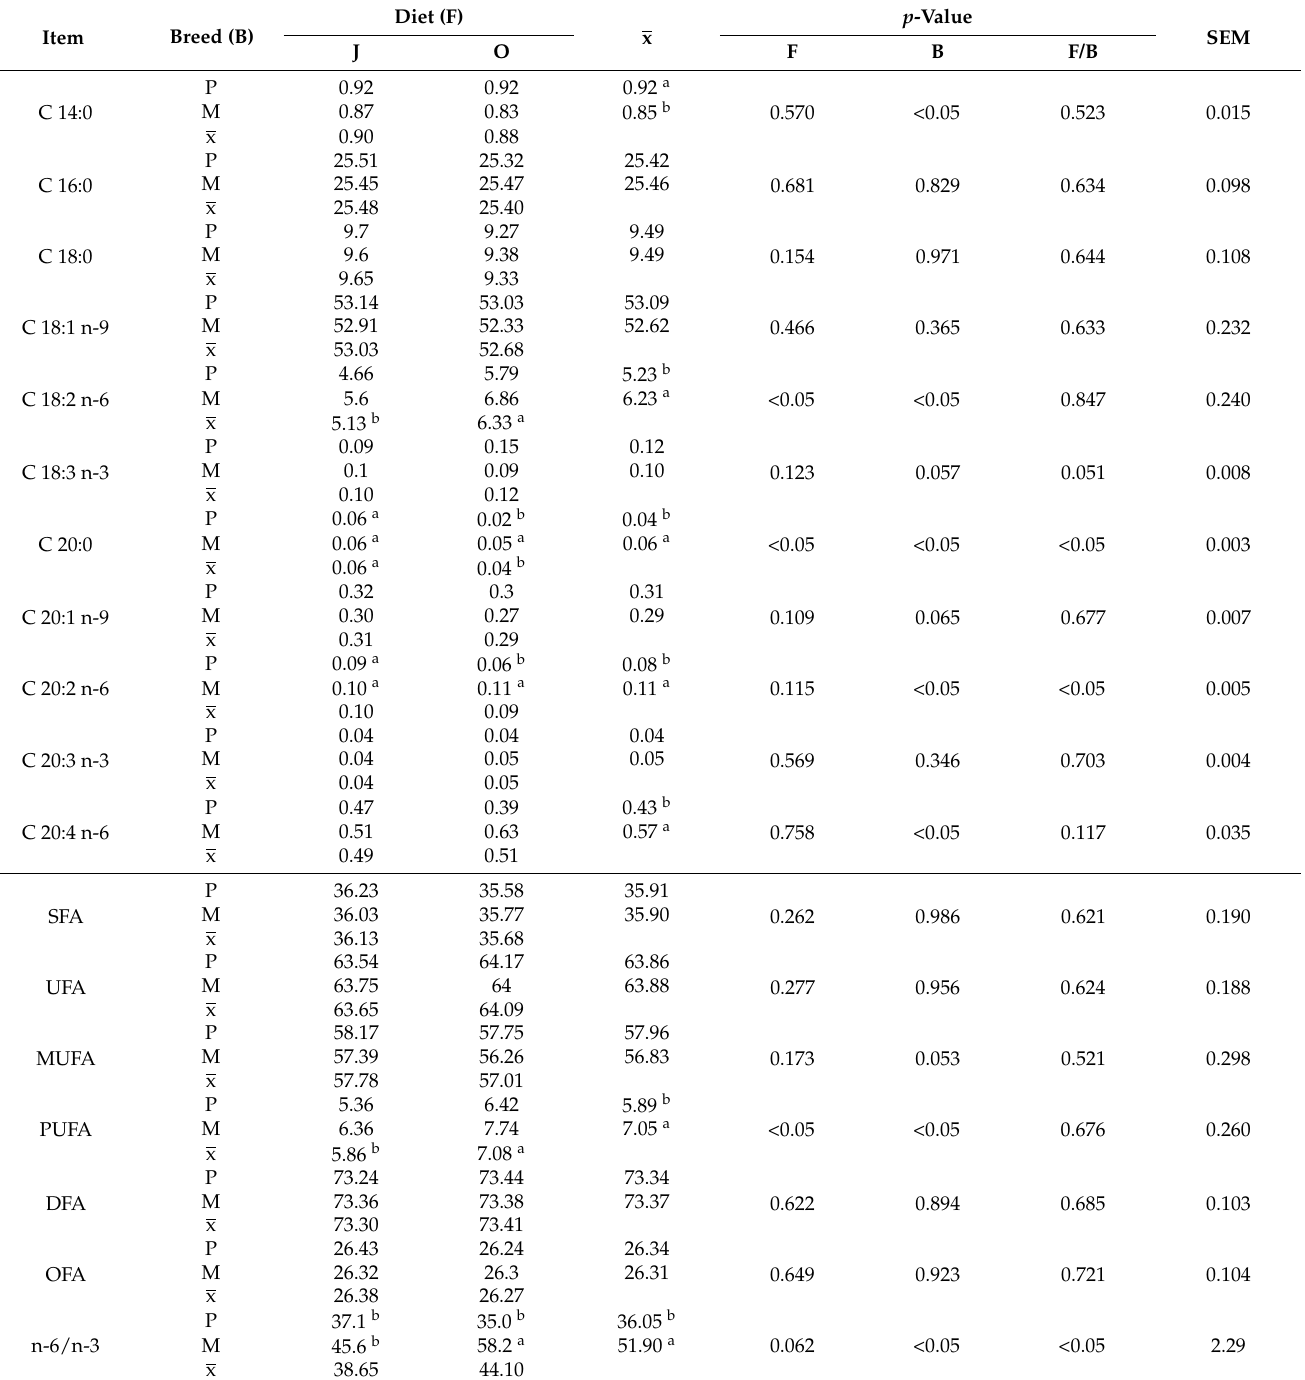
Table 8. Fatty acid profiles (% total FA) of semimembranosus